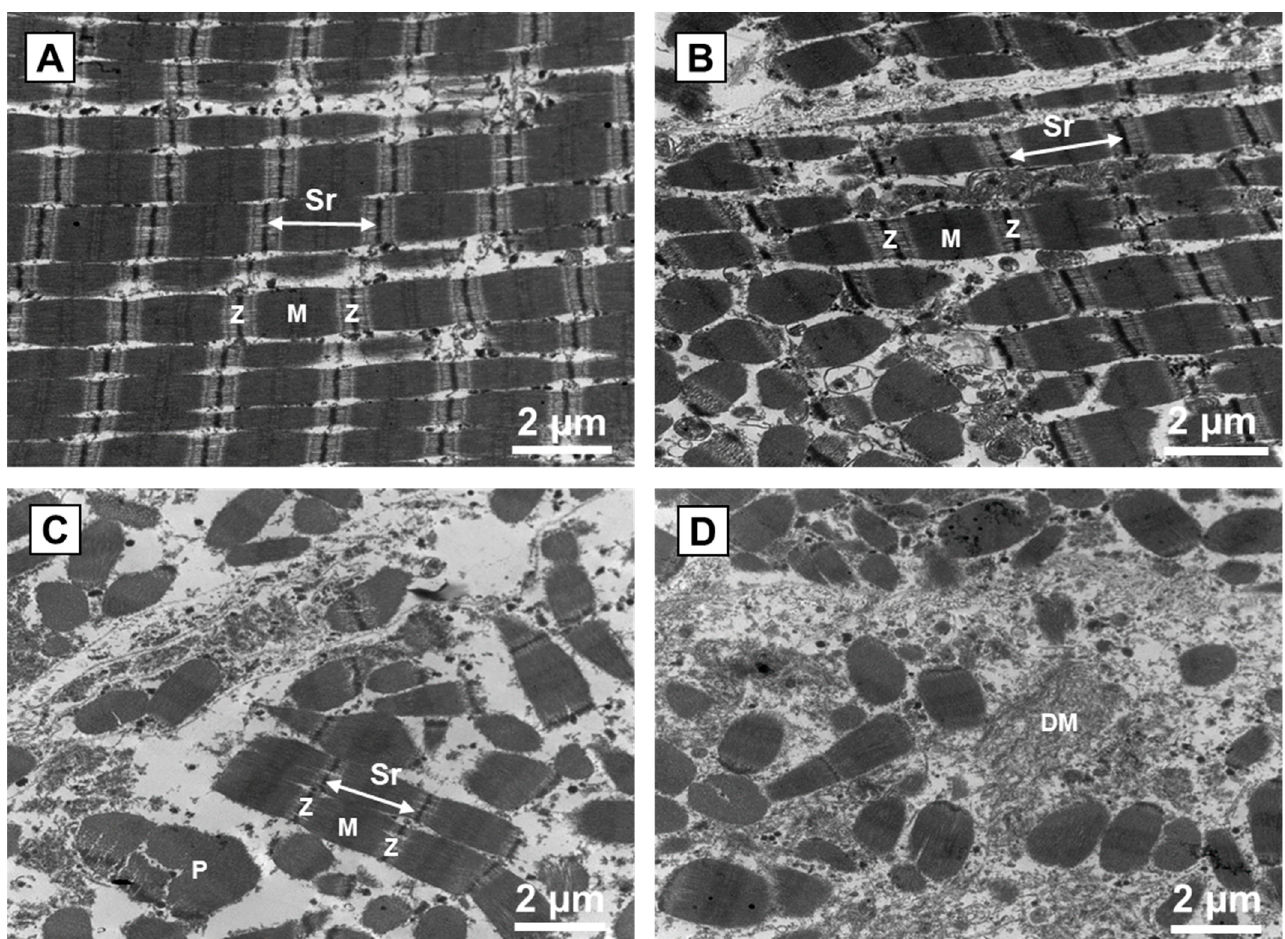
Figure 6. Ultrastructure changes occurred in the centre of raw meat pieces from beef Semitendinosus tumbled for different process times. ( A ): NT (control, no mechanical treatment); ( B ): T1 (2500 compression cycles, about 3 h); ( C ): T2 (6000 com- pression cycles, about 7.5 h); ( D ): T4 (13,000 compression cycles, about 16 h). Sr: Sarcomere; Z: Z ‐ line; M: M ‐ band; P: protein aggregation; DM: depolymerization of the myofilaments.